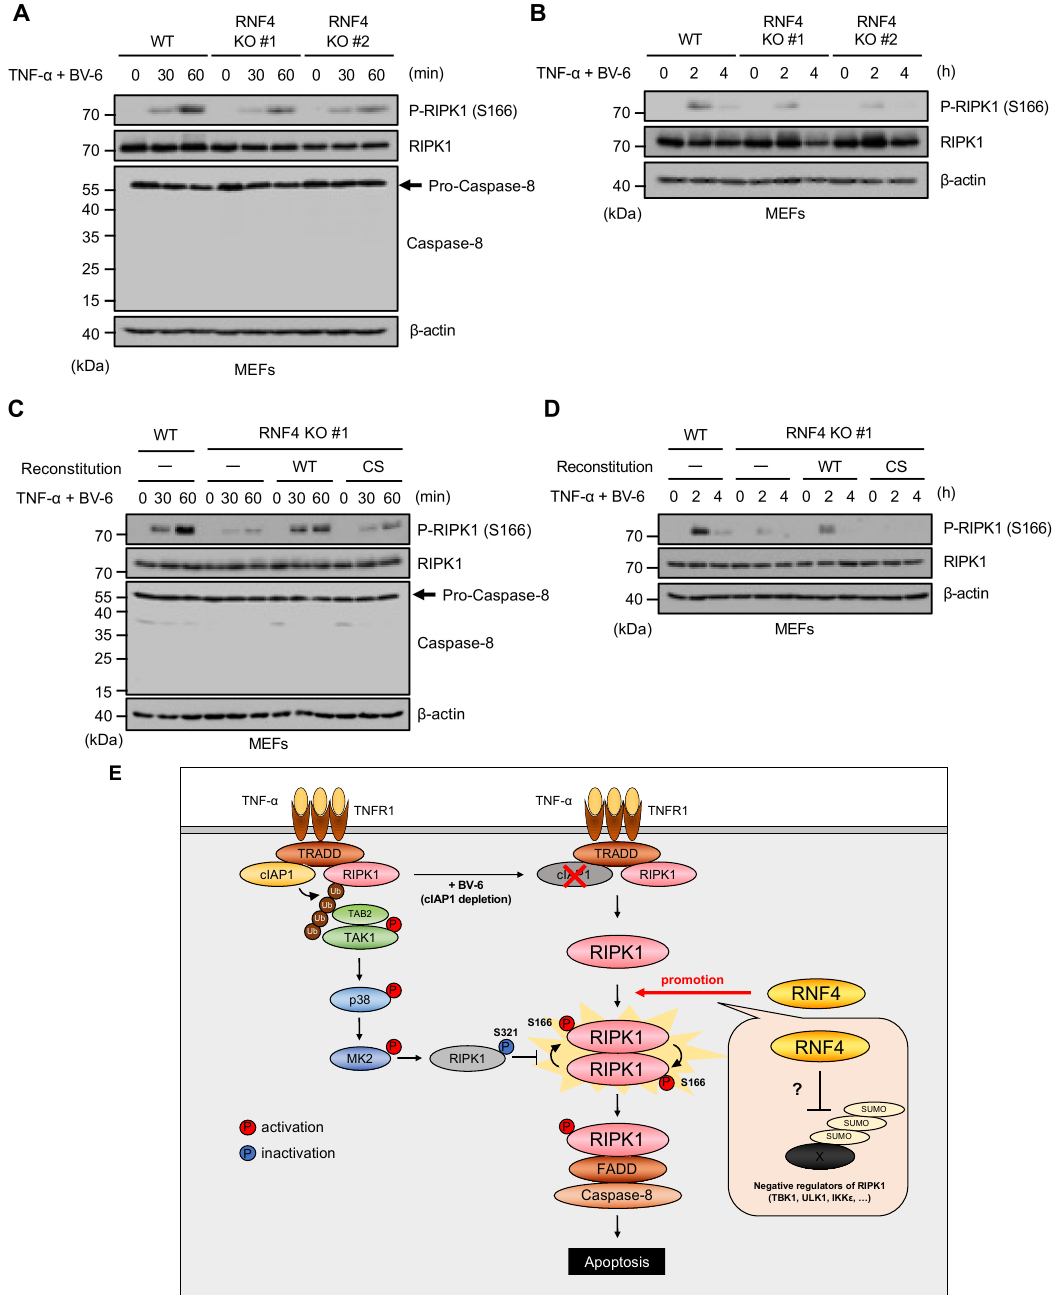
Figure 5. RNF4 promotes RIPK1-mediated cell death independently of its effects on the TAK1 signaling. ( A , B ) Autophos- phorylation of RIPK1 at Ser166 triggered by TNF- α . MEFs were treated with TNF- α (50 ng/mL) for the indicated periods